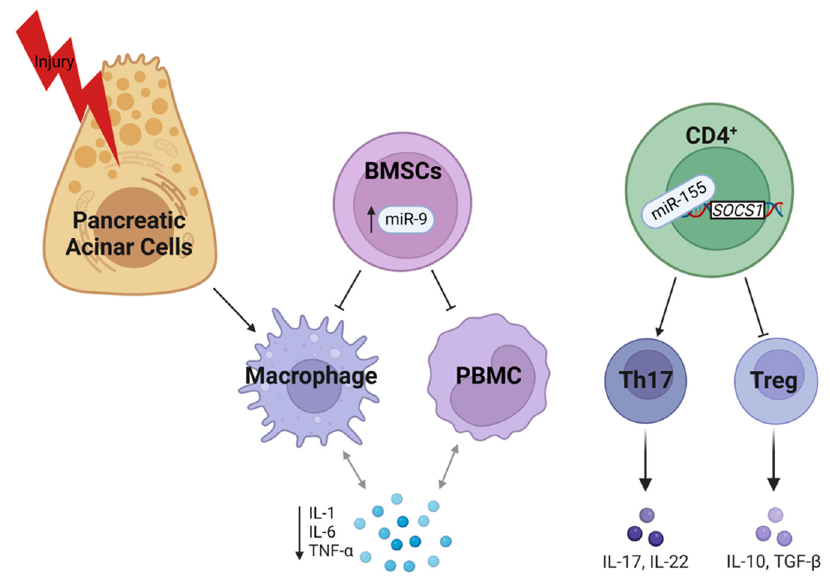
Figure 4. MiRs regulating inflammation and immune response in SAP (please see text for details). Created with BioRender.com.